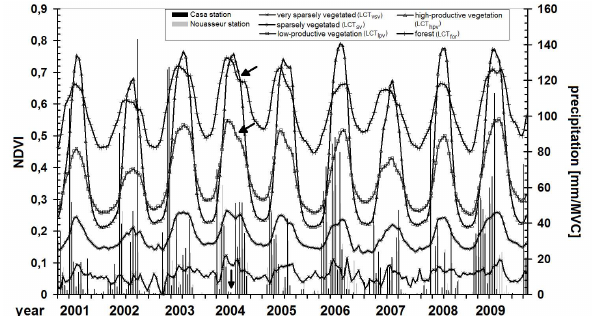
Fig. 12. Endmembers of stably classified areas and accumulated precipitation to composite length. Arrows show indicated influence of droughts due to a lack of precipitation from mid of December to mid of February in 2004.